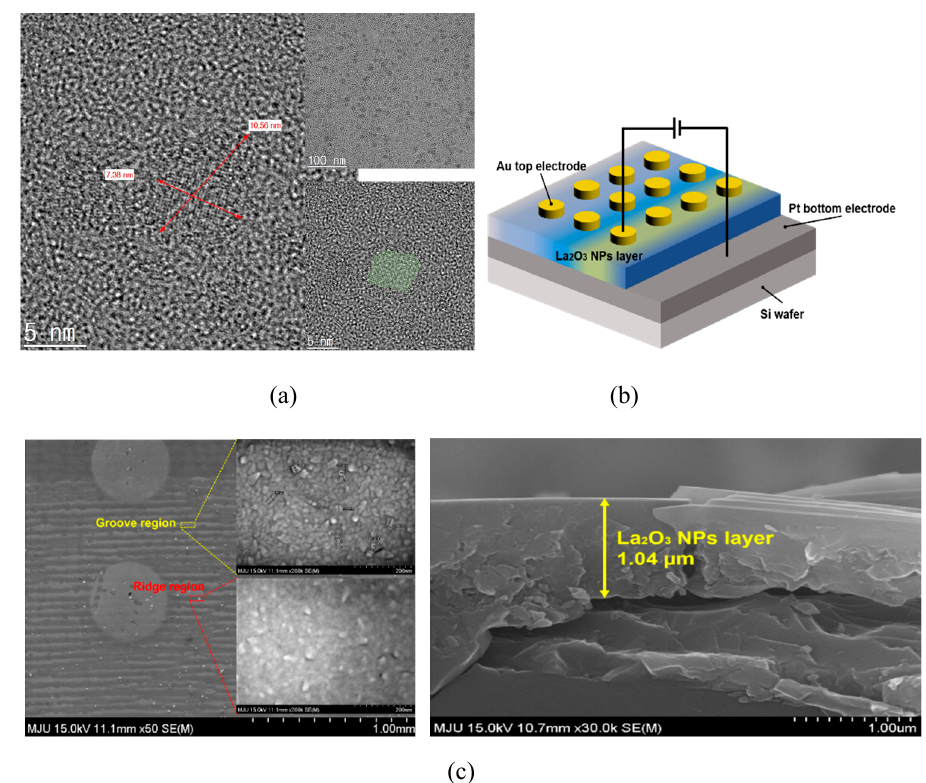
Figure 1. (a) TEM image of synthesized plate-shaped LaO x NPs, ( b ) schematic image of the Au/LaO x NPs/Pt device, ( c ) SEM image of groove/ridge pattern layer formed by LaO x NPs after dip-coating, annealing and Au top electrode evaporation, groove and ridge pattern region on Pt coated wafer.